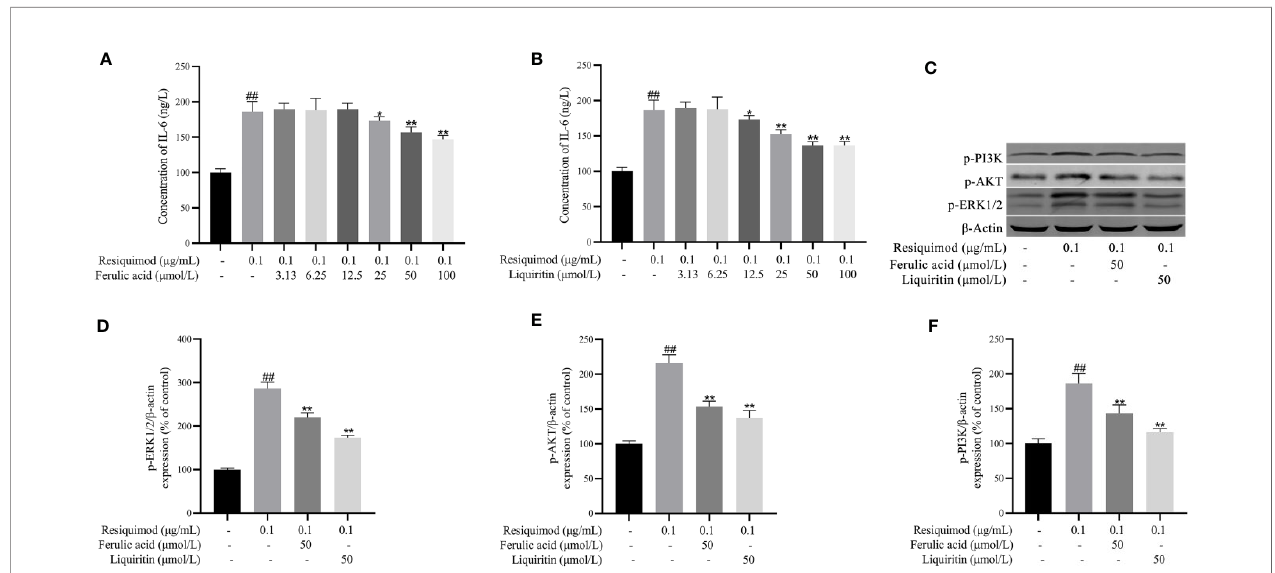
FIGURE 11 | Effects of ferulic acid (A) and liquiritin (B) on resiquimod-induced RAW 264.7 cells IL-6 cytokines expression and the protein expression of p-ERK1/2, p-AKT, and p-PI3K of resiquimod induced RAW264.7 cells (C – F) . ## p < 0.01, compared with control group. * p < 0.05, ** p < 0.01, compared with the resiquimod